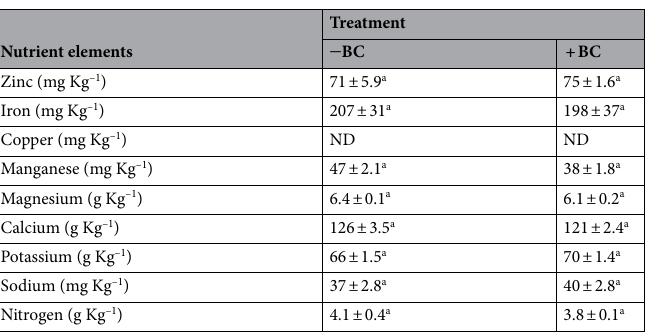
Table 1. Effect of absence ( ‒ BC) and presence (+ BC) of biochar on the nutrient element levels of Arabidopsis thaliana plants grown for 21 days. Data presented are mean ± standard error ( n = 3) and different letters indicate significant ( p ≤ 0.05) differences with each other ( ‒ BC and + BC) (ANOVA, Tukey test). ND—not